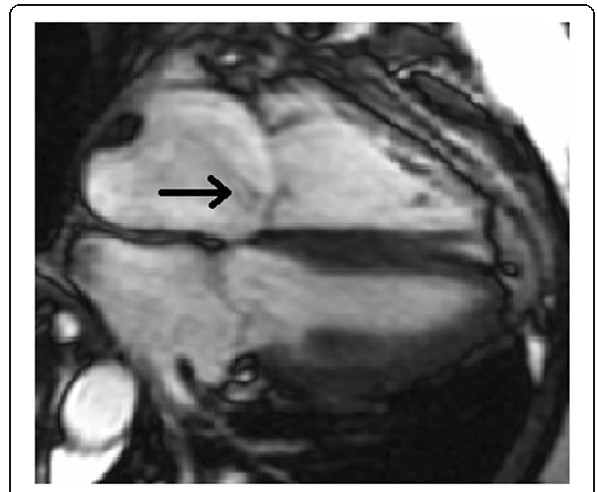
Fig. 6 Tricuspid regurgitation in a dilated right ventricle and right atrium. Fiesta cine sequence MRI image demonstrates a four-chamber